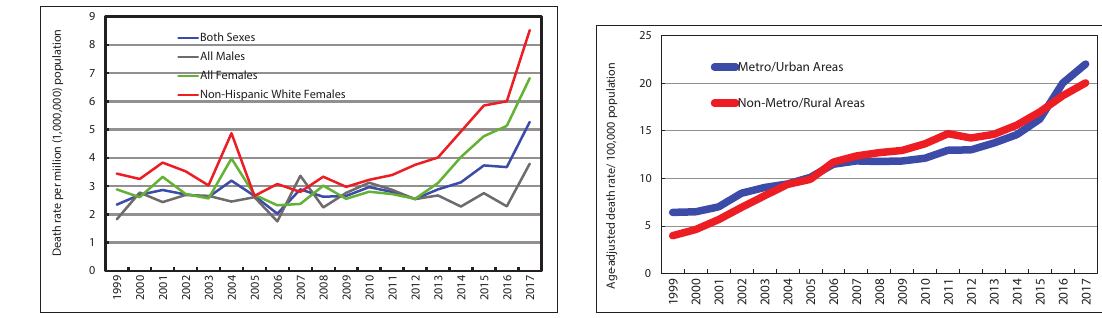
Figure 7: Trends in Drug Overdose Mortality in Urban and Rural Areas, United States, 1999-2017 Source: Data derived the National Vital Statistics System, Nation - al Mortality Database.